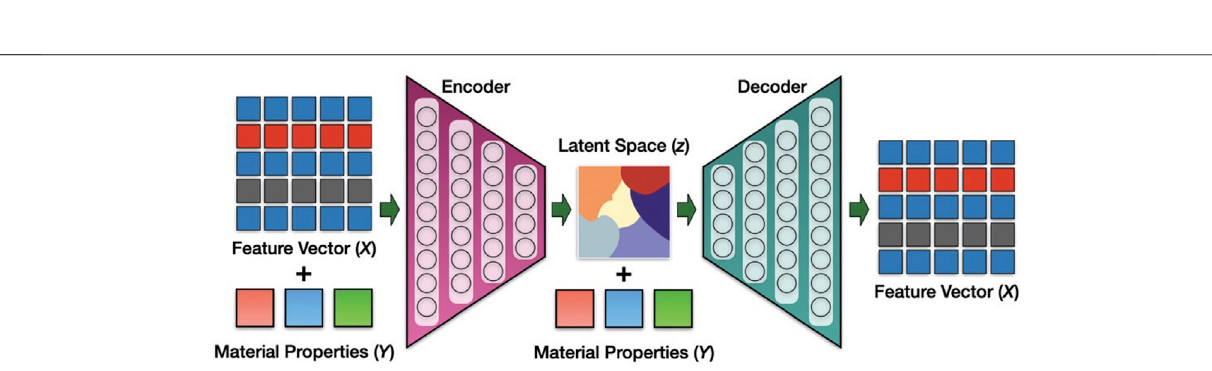
Frontiers in Materials |